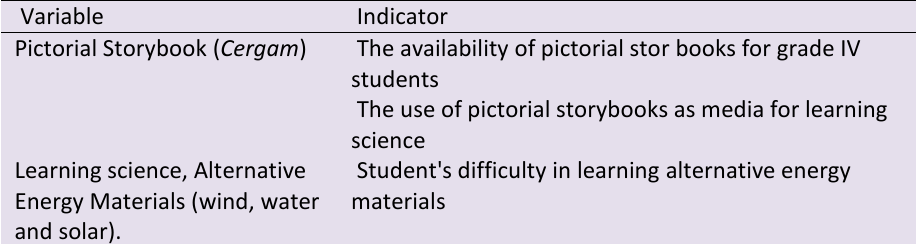
Table 3 . Outline of Questionnaire for Students